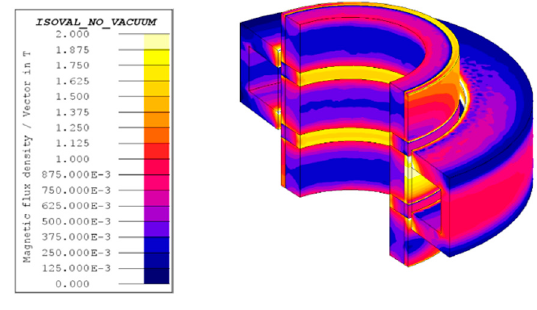
Figure 3. Flux density (skewing angle 75°).